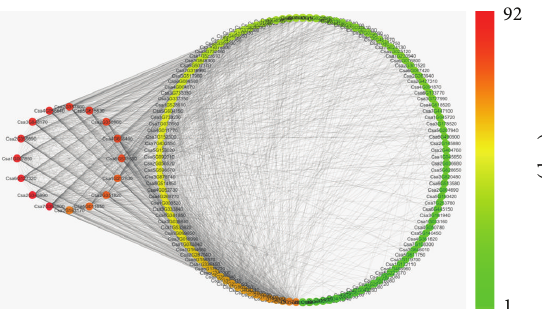
Figure 7: Visualization of a coexpression network of 150 of 208 genes in the blue module. The network TOM similarity was calculated with a power of 30 and edges are of weight higher than 0.25. The 16 hub genes of the highest network degree (60–92) are shown on the left panel of the